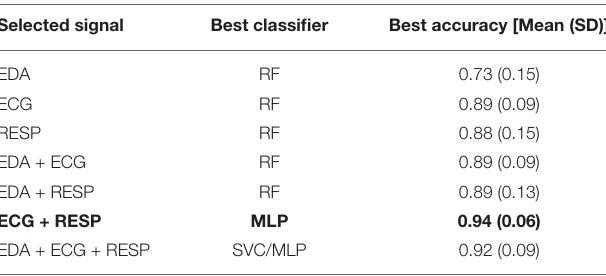
TABLE 5 | Best score for each combination of selected signals (with a segmentation level of 1). Selected